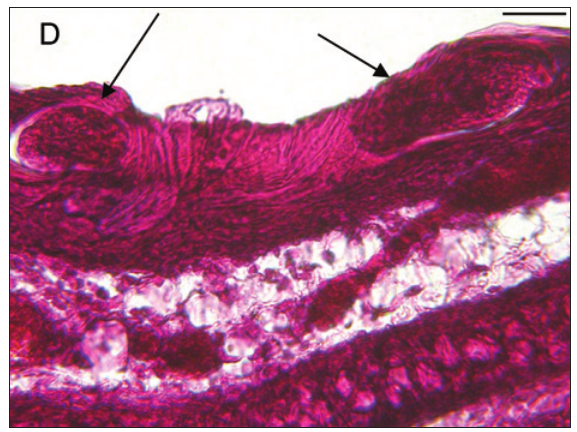
Fig. 7. – Trichosomoides nasalis (arrows) in the pseudostratified epithelium. A, two sections of a female (short arrows) with intrau- terine male (long arrow). B, a female and inflammatory reaction. C, detail of an intrauterine male. D, female beneath the keratinized upper part of the pseudostratified epithelium which is stretched and distorted by worm movements. Scale bars in μ m: A, D, 50; B,